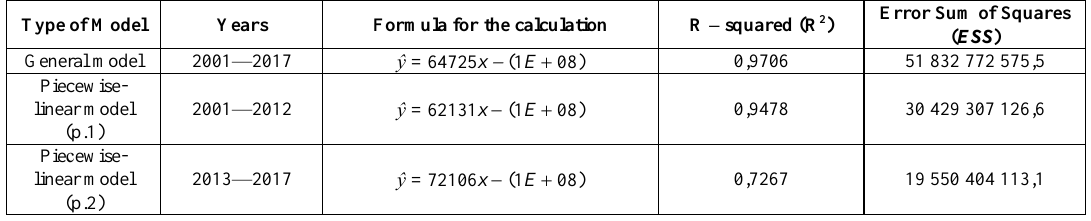
Table 3. Regression models describing exports dynamics of pharmaceutical products from the EU to Israel Type of Model Years Formula for the calculation R – squared (R 2 )